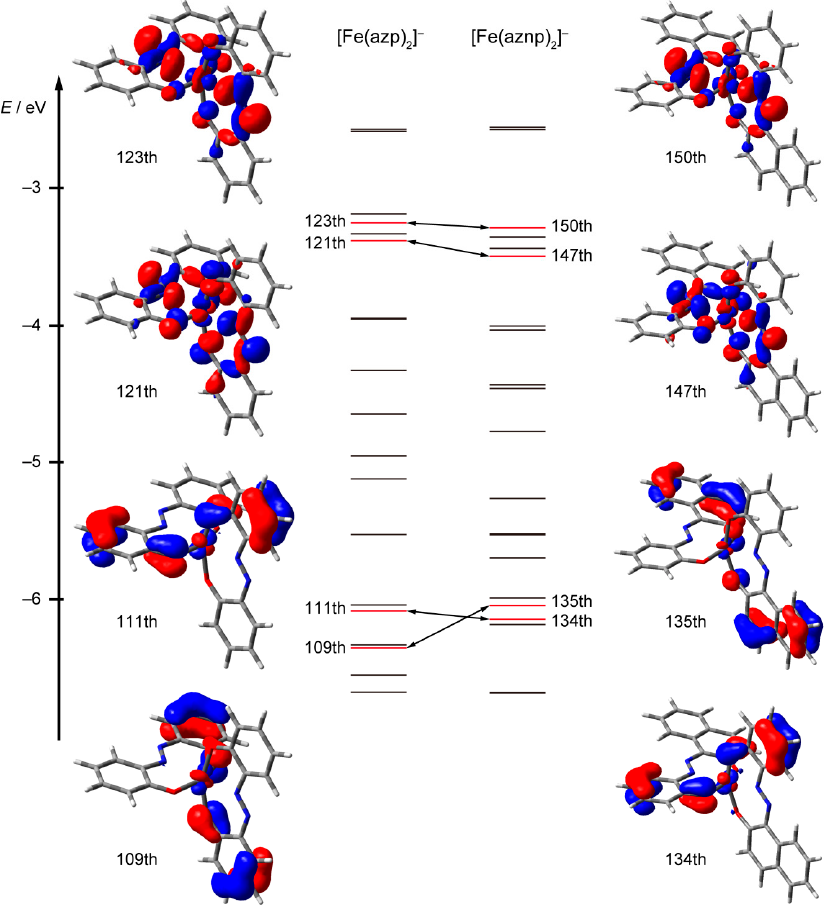
Figure 8. Energy level diagram of the frontier occupied α -spin MOs for HS [Fe(azp) 2 ] and HS [Fe(aznp) 2 ] anions. Red energy levels indicate the MOs containing Fe d-orbital contributions and these surfaces are shown. Double-head arrows indicate the corresponding MOs between HS [Fe(azp) 2 ] and HS [Fe(aznp) 2 ]